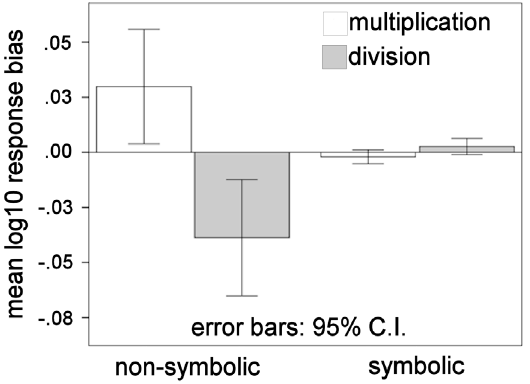
Figure 4. Operational momentum (OM) in non-symbolic, but not symbolic, notation. A significant response bias occurred for non- symbolic problems, indicating an OM effect. Symbolic response bias was not significant. Non-symbolic multiplication (light grey) problems were overestimated and division (dark gray) problems were underes- timated. Response bias was calculated as the log 10 response value – log 10 correct value. Positive response bias indicates overestimation and negative indicates underestimation. Error bars represent 95% confi- dence interval (C.I.). doi:10.1371/journal.pone.0104777.g004 PLOS ONE |